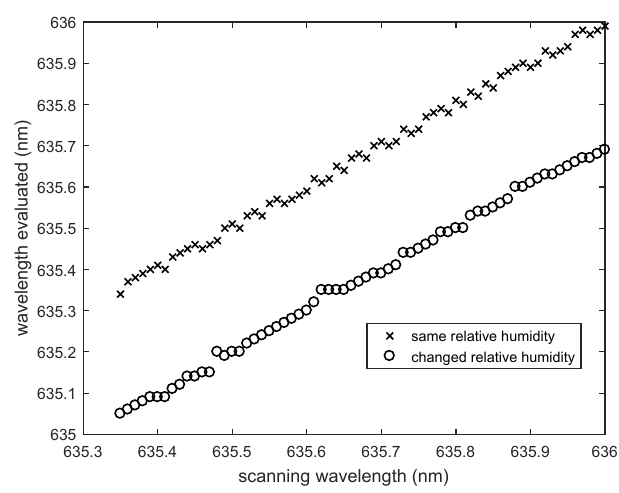
Figure 4. Comparison of scanning wavelengths and determined wavelengths, if the relative humidity changes (circles) or remains constant (crosses).